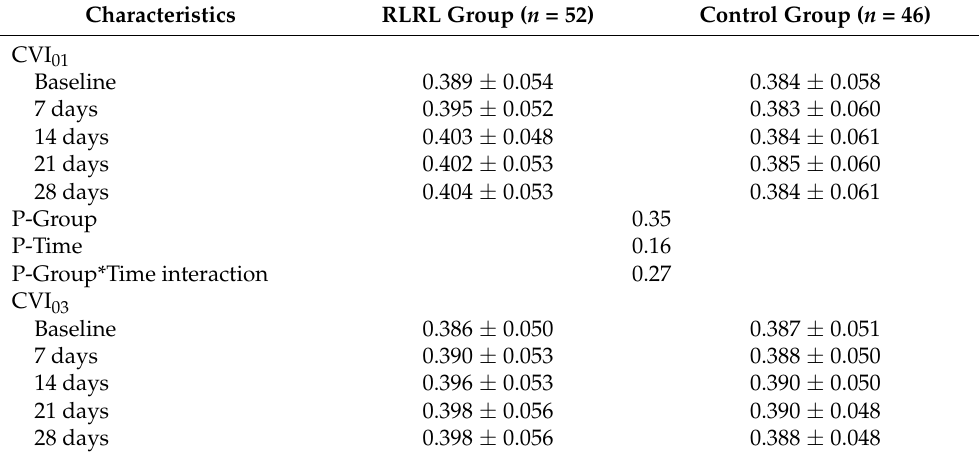
Table 2. Change in choroidal vascularity index at different periods (mean ±